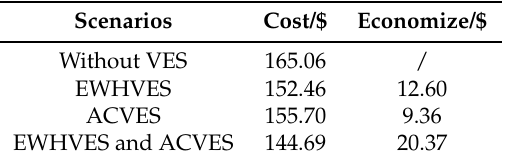
Table 4. Daily operating costs of the system under 4 scenarios.